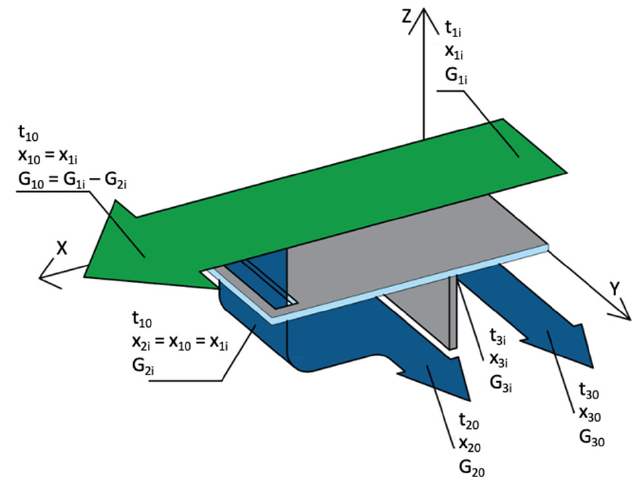
Figure 2. Initial conditions for the multi-stage dew-point evaporative cooler. Table 2. Analyzed dew-point evaporative cooler operating parameters.